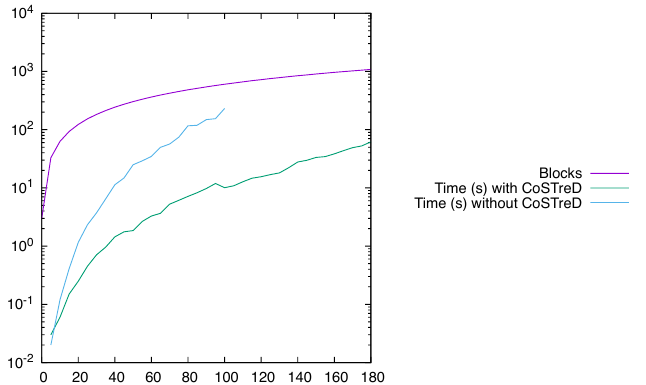
Figure 20. Performances of the IsamDAE tool for the structural analysis of long modes of the transmission line model. The abscissa is the number N of lump elements in the transmission line. The purple curve gives the number of blocks of the Conditional Dependency Graph (CDG). The blue curve is the processor time (in seconds) with CoSTreD disabled, while the green curve gives the processor time with CoSTreD